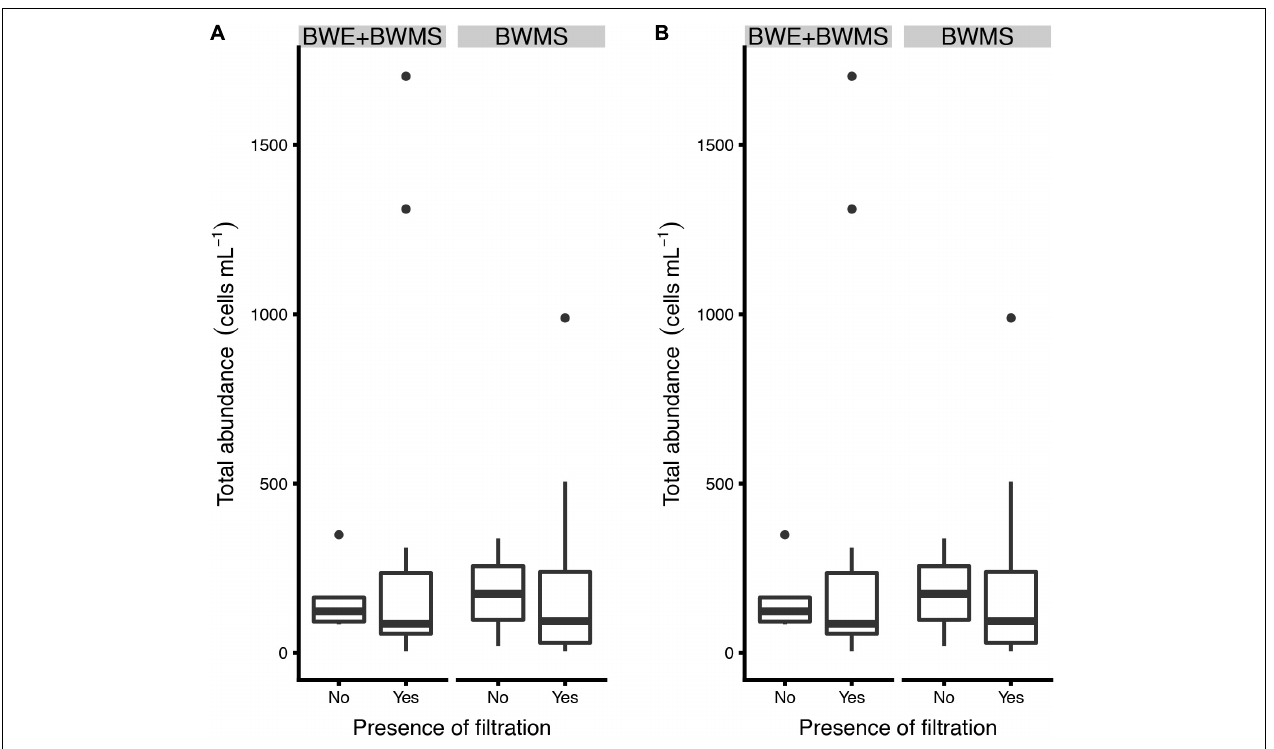
FIGURE 3 | Estimated abundance of (A) total and (B) harmful phytoplankton species present in preserved ballast water samples collected from ships using BWMS with or without a filtration step; ships using a combined strategy of ballast water exchange and treatment (BWE + BWMS) are shown separately from those using a BWMS alone. In the box plots, the boundary of the box closest to zero indicates the 25th percentile, the black line within the box marks the median, and the boundary of the box farthest from zero indicates the 75th percentile. Whiskers above and below the box indicate the 10th and 90th percentiles. Points above the whiskers indicate outliers outside the 90th